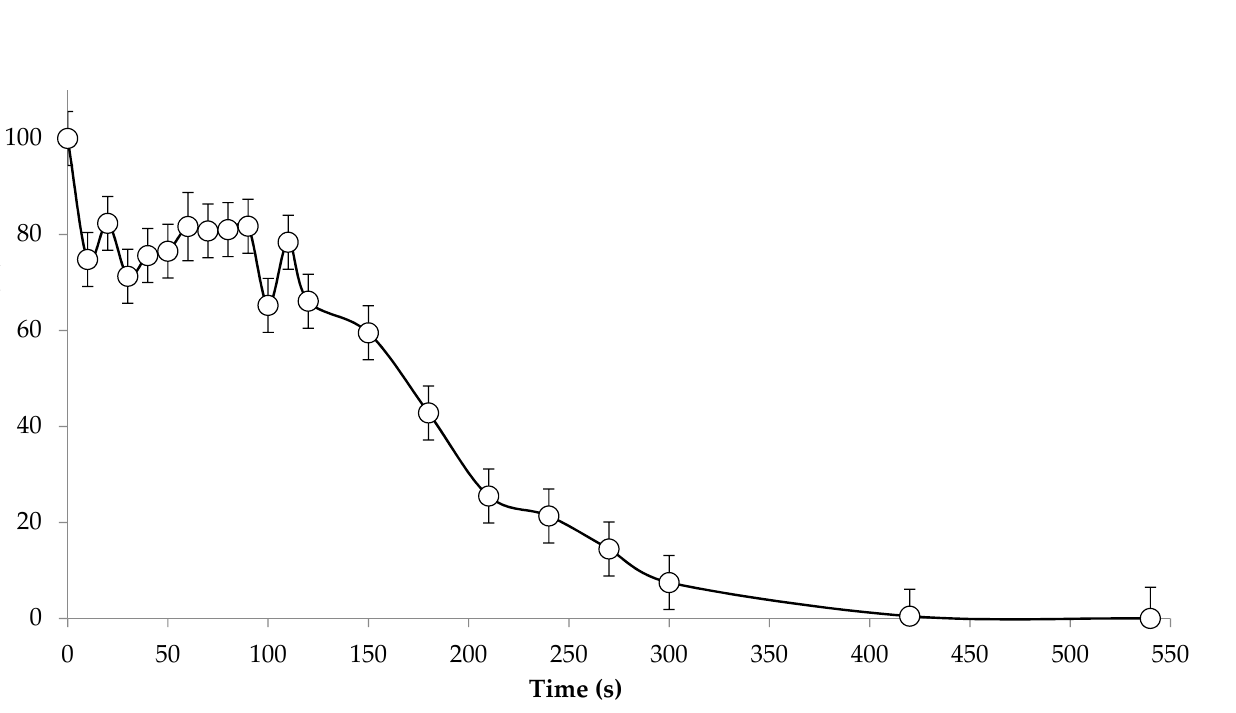
Figure 2. Survival rate of S. suaveolens under UV exposure. The values are rom eight independent experiments with standard value presented as vertical bar.